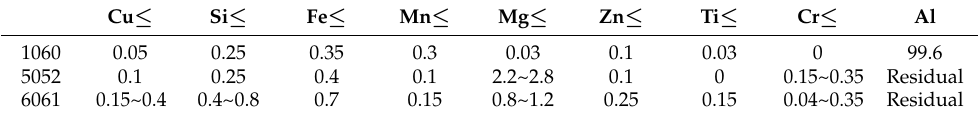
Table 2. Chemical composition ratios of the different grades of aluminum blocks